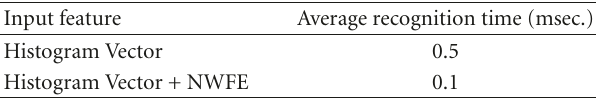
Table 1: Action recognition using di ff erent features.